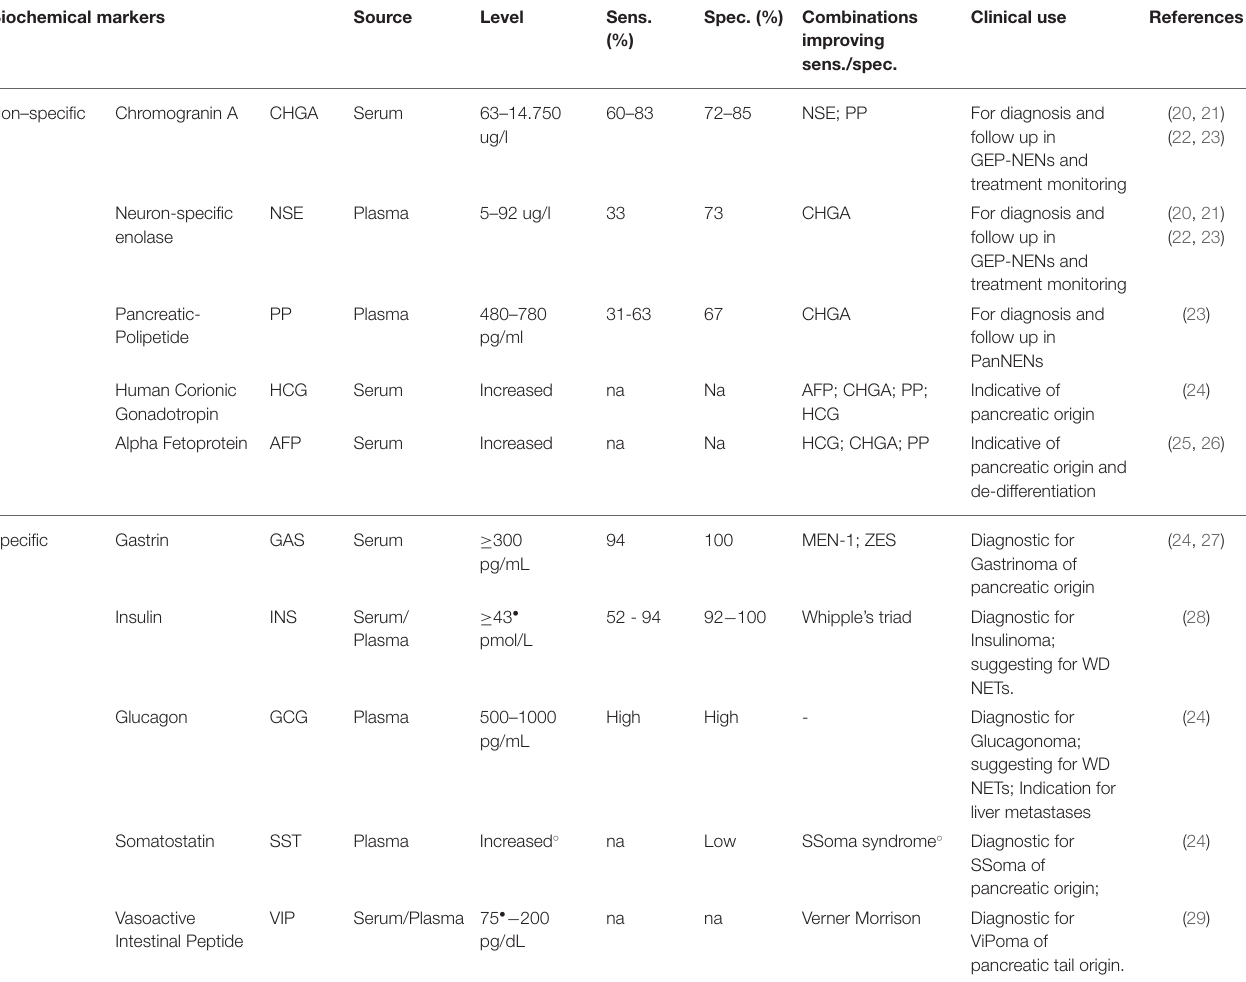
TABLE 2 | Biochemical biomarkers in use for PanNEN diagnosis, prognosis, and treatment monitoring. Biochemical